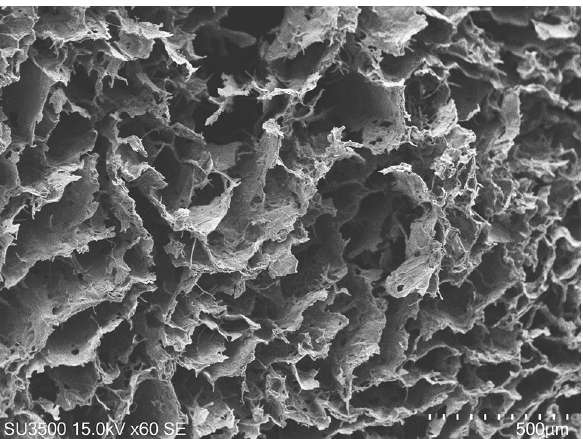
Figure 4. The SEM image shows the morphology of nanochitosan/PPy–Alg scaffold which is prepared with ratio 2:10 polypyrrole–alginate composite.